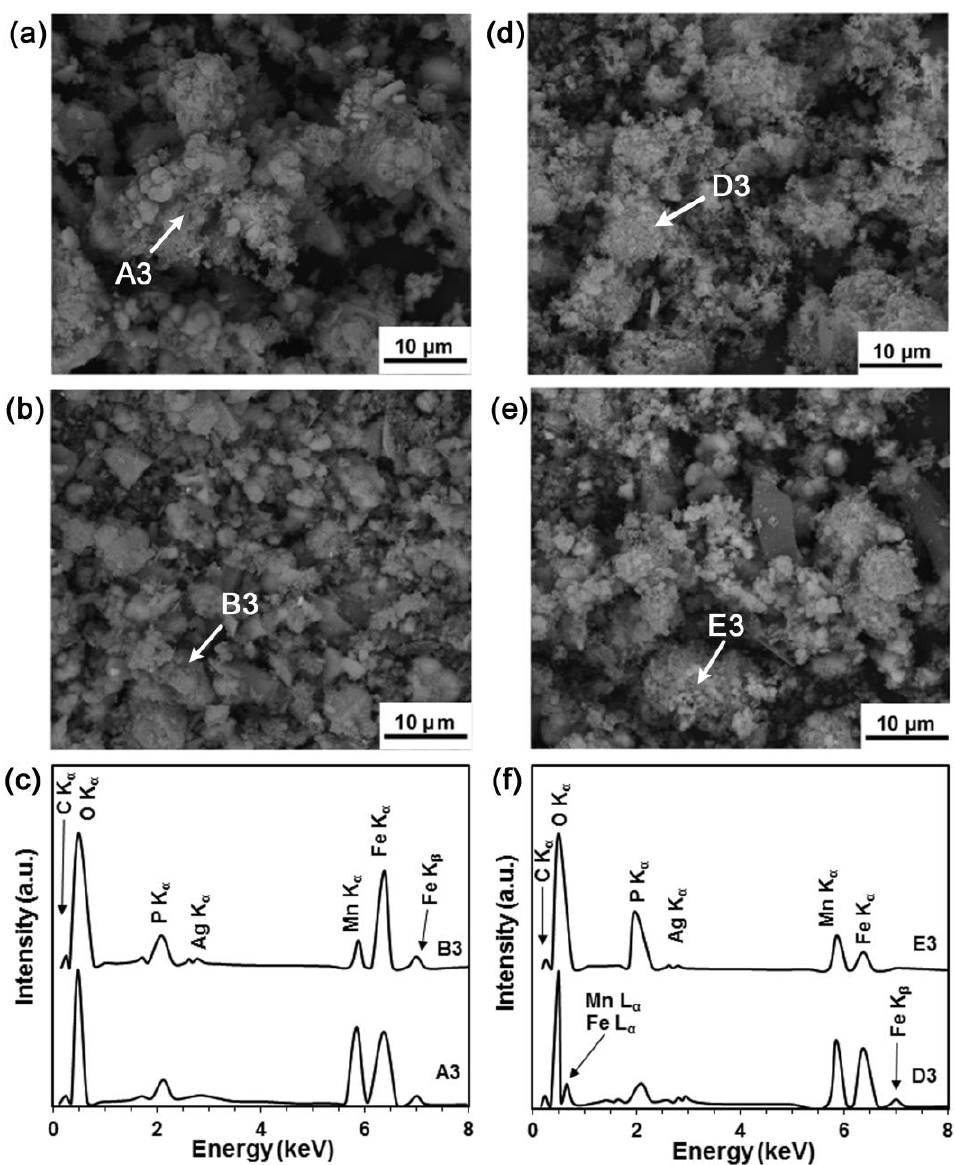
Figure 8. Degradation products after 14 days of immersion in MHBSS from ( a ) the MP and ( b ) PT conditions; ( c ) EDS for points A3 in ( a ) and B3 in ( b ). Analysis of the powders collected from the bottom of the solution, for ( d ) the MP and ( e ) PT conditions; ( f ) EDS for points D3 in ( d ) and E3 in ( e ).